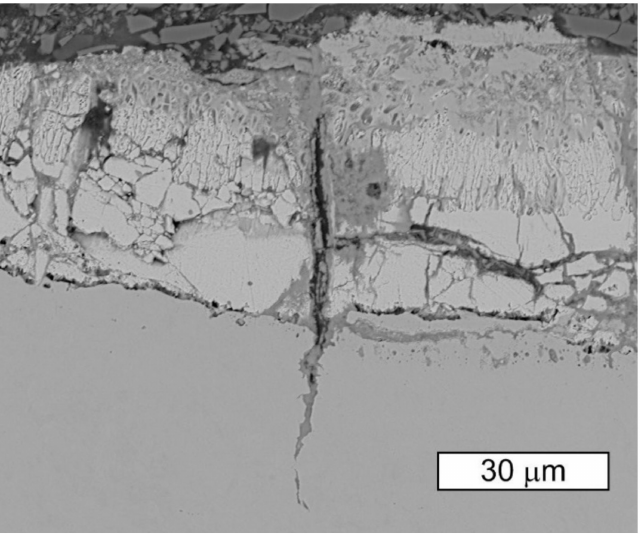
Figure 11. SEM image of the longitudinal section of the S1 bolt thread root (BSD). Visible radial cracks of the zinc coating and steel substrate cracks filled with corrosion